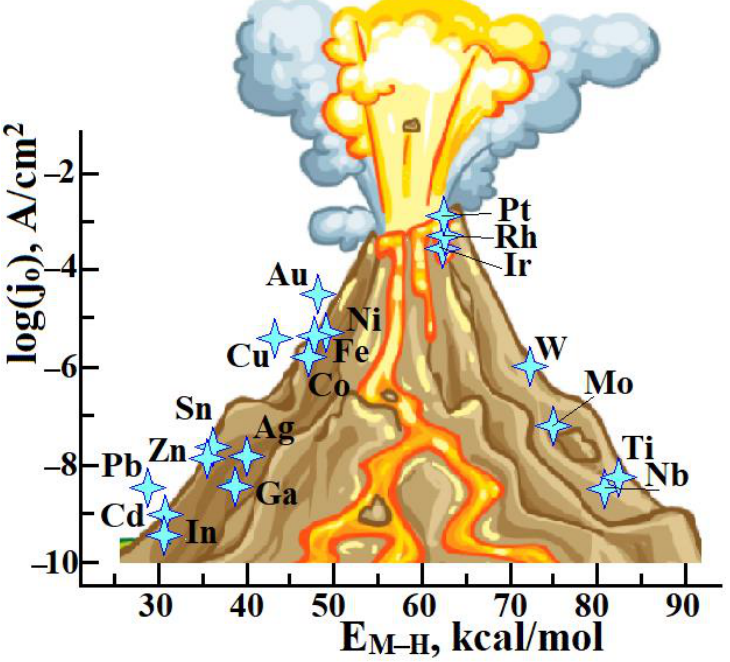
Figure 10. Dependence of exchange current density vs. the M–H bond energy in acidic media (according to [306]).